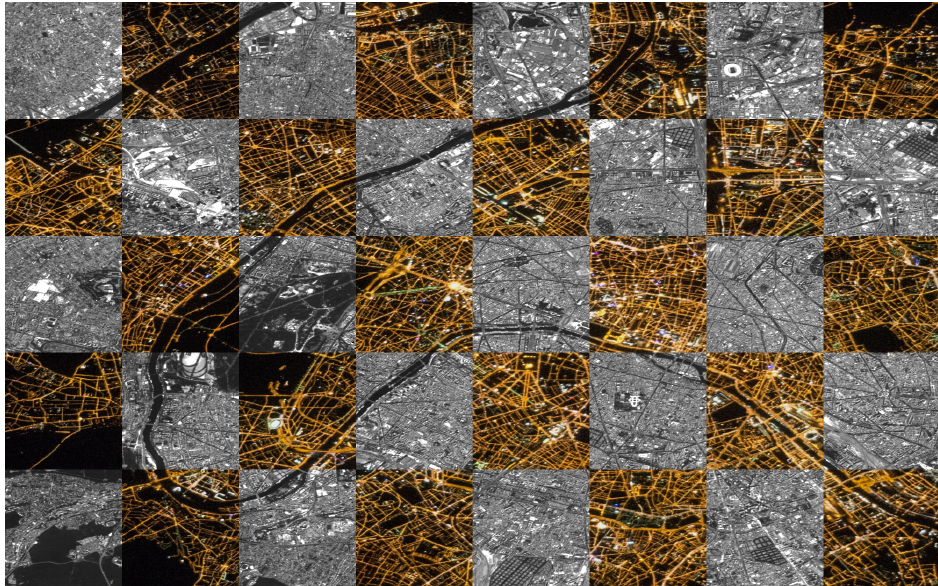
Figure 9. Subsection of georeferenced NTL image of Paris (color image) overlaid onto reference Sentinel-2 image